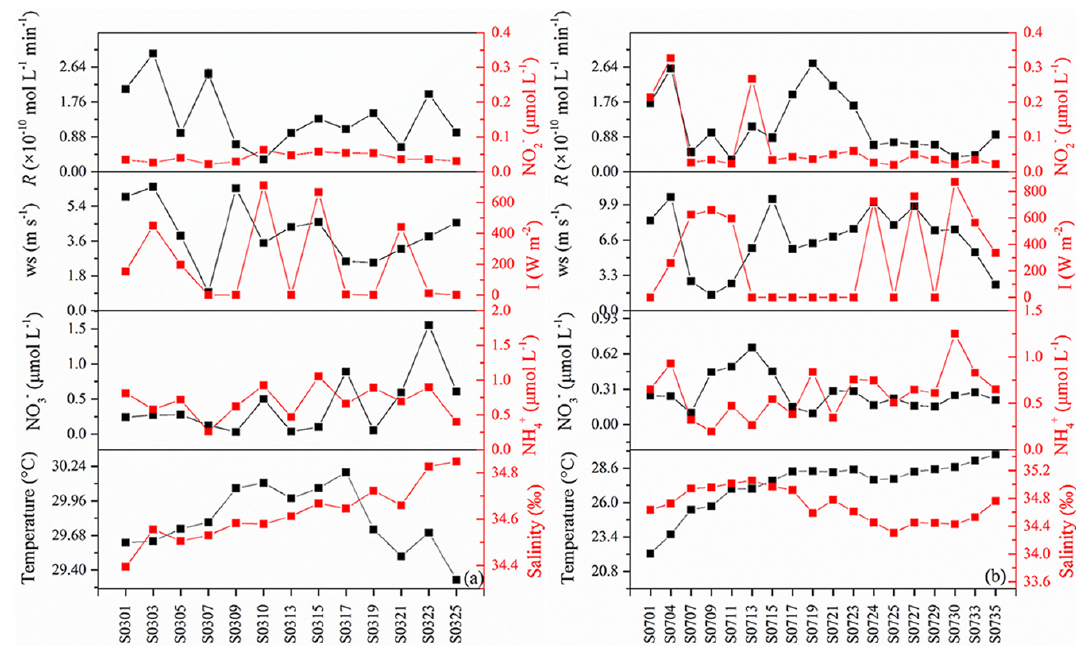
Figure 6. Seawater temperature; salinity; concentrations of NO −